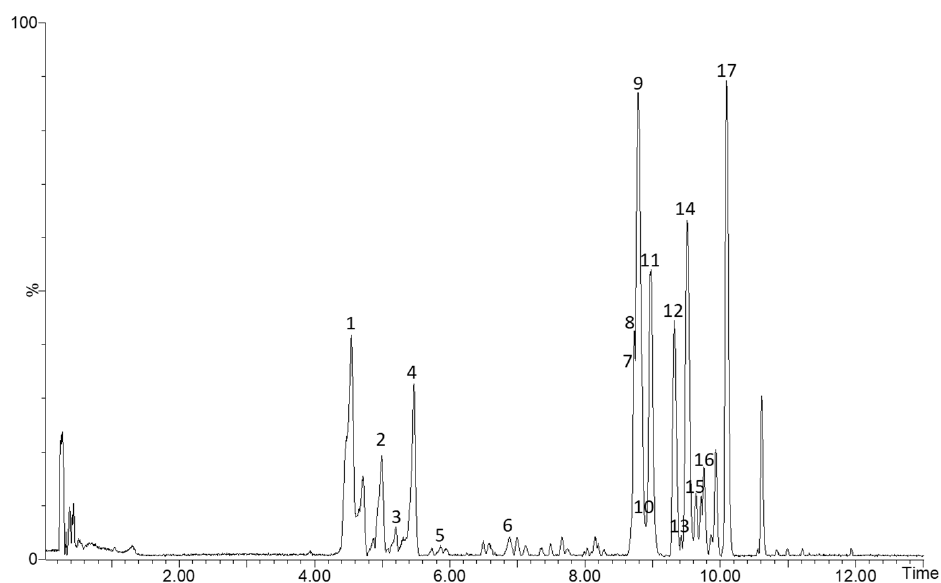
Figure 1. HPLC–TOF–MS chromatograms of apple pomace without seed extracts. 1: caffeoylquinic